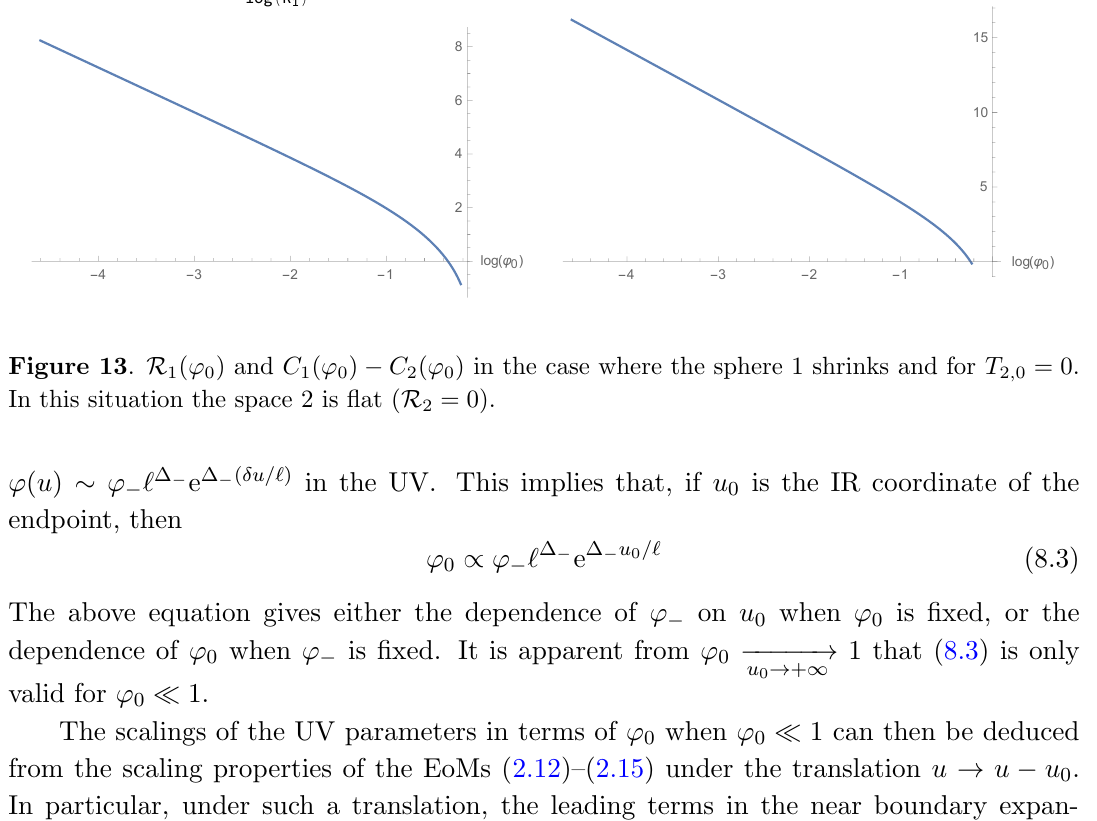
p (cid:0) V ( ’ ) = 3. In the case of